Question: Generate an informative caption for the figure above.
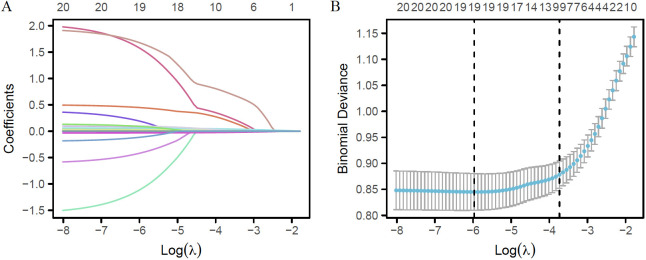
Answer: Identification of clinical predictors via LASSO regression. (A) Coefficient profiles of features across the regularization path. (B) Ten-fold cross-validation for optimal lambda selection (lambda.1se) using the one-standard-error rule, yielding the final parsimonious predictor set.